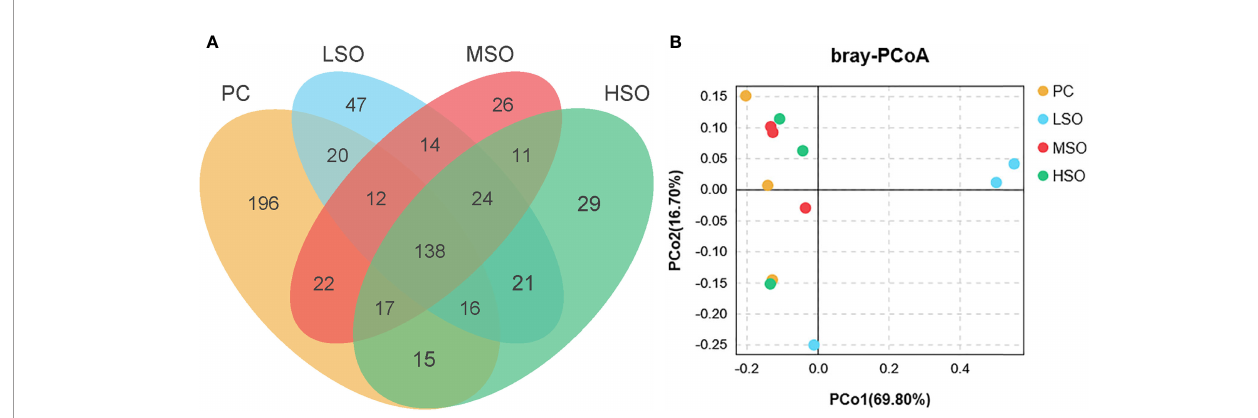
FIGURE 4 | Mid-intestinal microbiota responses of L. vannamei fed with experimental diets. (A) Venn diagram of shared and unique OTUs of shrimp in this study. (B) Principal coordinates analysis (PCoA) based on Bray analysis of shrimp in this study. Note: Vertical bars represent the mean ± SD ( n = 3). Data marked with different letters differ signi fi cantly ( p < 0.05) among groups based on Tukey ’ s multiple